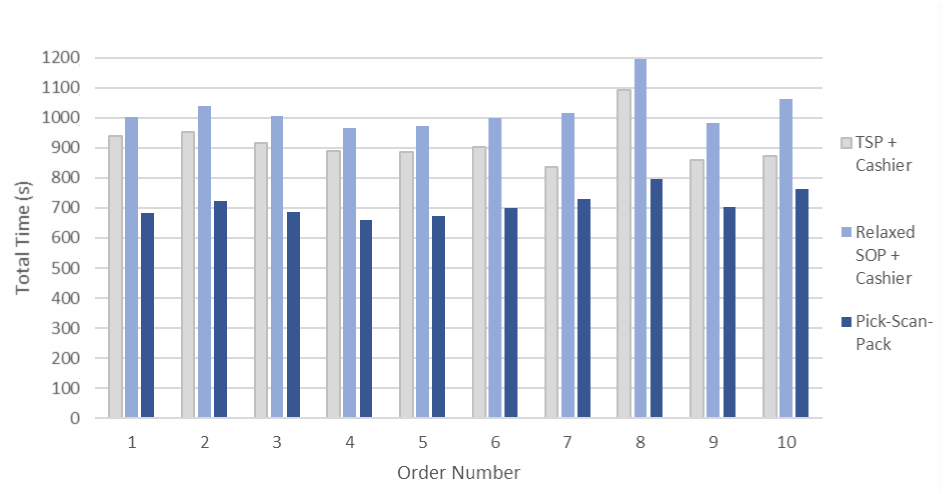
Figure 5. Histogram of simulations on total time for the 10 BOPS orders in three different